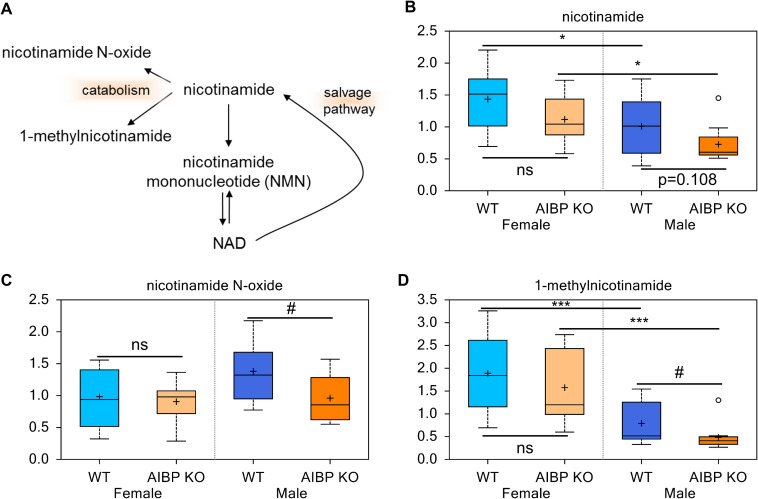
AIBP modulation of NAD metabolism.A. NAD biosynthesis pathways. Measurements of plasma content of nicotinamide (B) nicotinamide N-oxide (C), and 1-methylnicotinamide (D). #: 0.05<p<0.1; ns: not significant (p>0.1). ***:p<0.001.